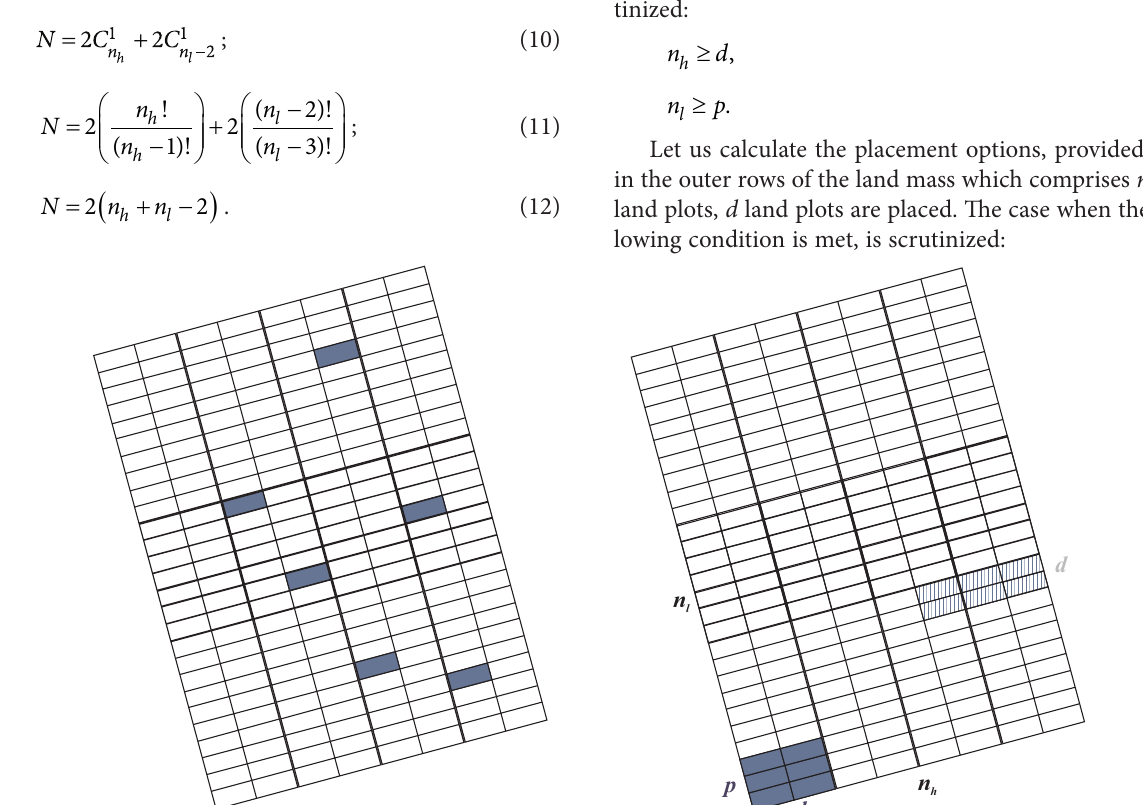
Figure 5. Land plots consolidation with the placement of a fixed number of land plots at the land mass